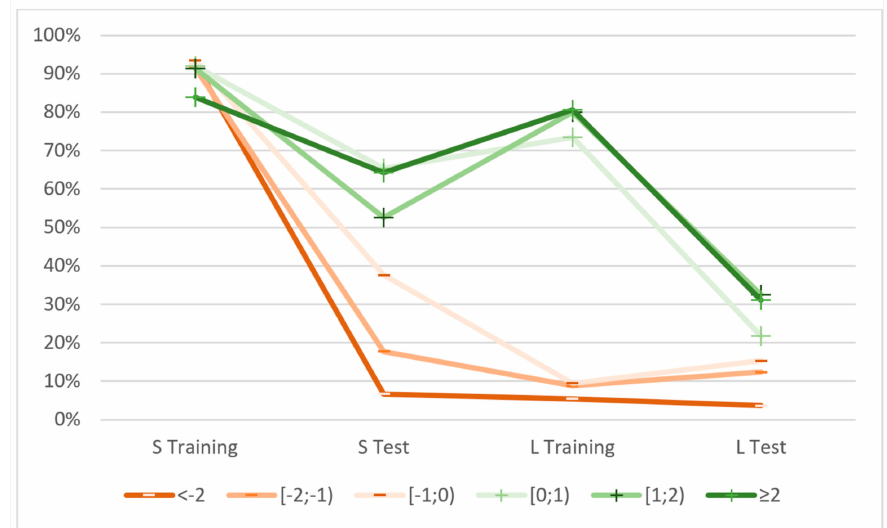
Figure 12. Percentage share of the sum of values obtained from buy signals of the best networks (for %MP and pNEP indicators) achieved for a given value class. Note: S is the best network based on pNEP and L based on %MP